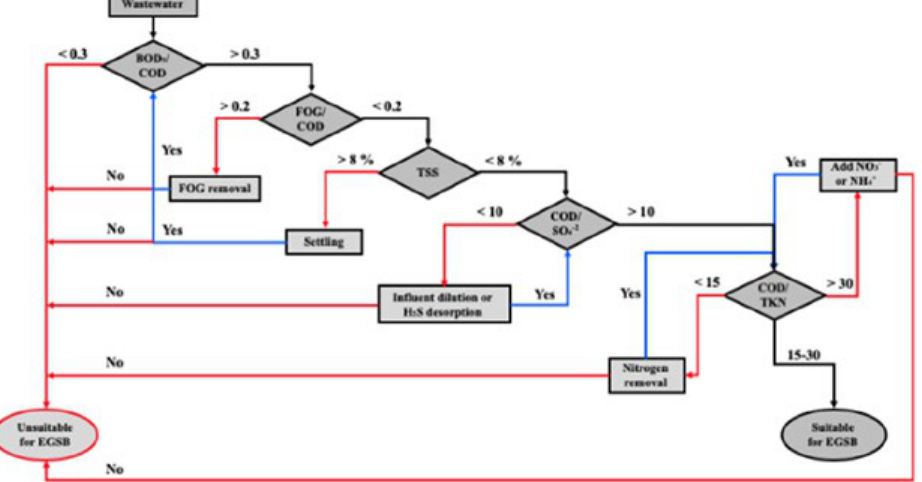
Fig. 4: Structure of the decision tree to identify the wastewater to suitable for EGSB bioreactor